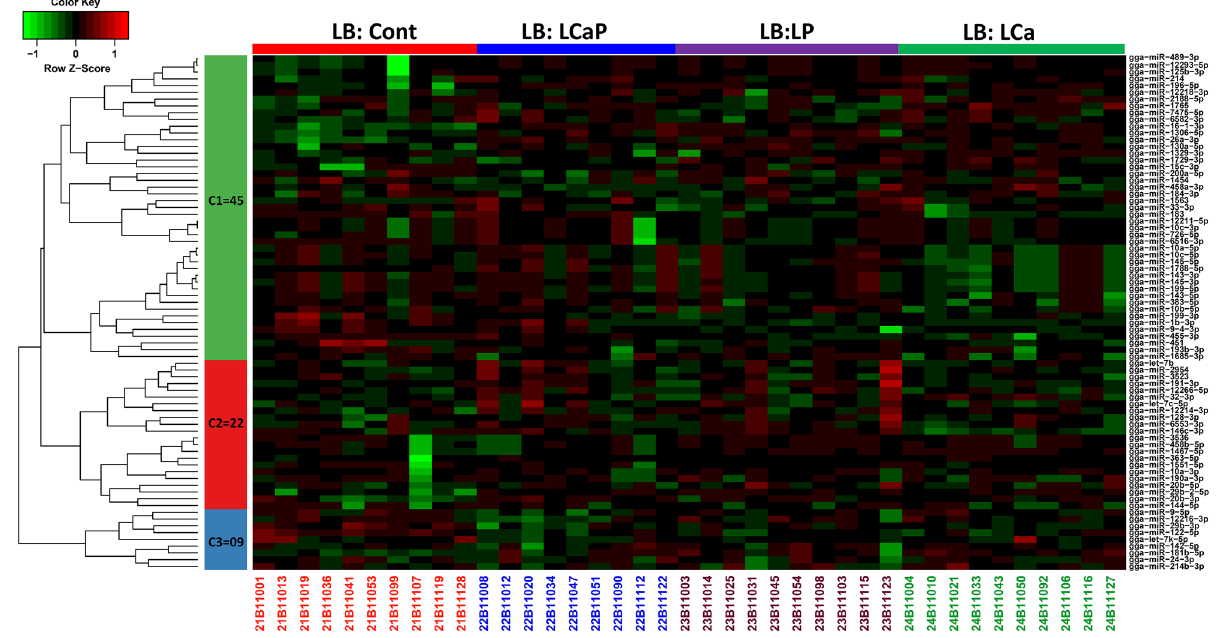
Figure 2. Expression profile of known miRNAs between diet groups within LB strain. Heatmap of miRNA expression profiles was generated in the R Programming environment (version 3.4.3) (https:// www.R- proje ct. org/) by using the hierarchical clustering method of heatmap.2 function of gPlots (version 3.0.1) (https:// CRAN.R- proje ct. org/ packa ge= gplots). MiRNAs were assigned to three clusters based on their co-expression with cut-off criteria of variance-stabilizing transformations ≥ 2, |logFC ≥ 1|. A total of 76 differentially expressed known miRNAs were distributed in three clusters including 45, 22 and 9 miRNAs in cluster one, two and three respectively. In color key: green color represents downregulation, red color represents upregulation and black color represents no change in tively correlated with 336 DE target genes which passed the significant threshold of FDR < 0.05, 24 DE miRNAs showed no correlations (Fig. 4). Out of 336 DE target genes in LB diet groups, 192 were upregulated and 144 were downregulated (Fig. 4). Moderate negative correlation ranged from − 0.30 to − 0.35 and strong negative correlation ranged from − 0.35 to − 0.60 in LSL strain, whereas in LB strain modest negative correlation ranged from − 0.30 to − 0.35 and strong negative correlation ranged from − 0.35 to − 0.80 with respect to their correlation coefficient score.